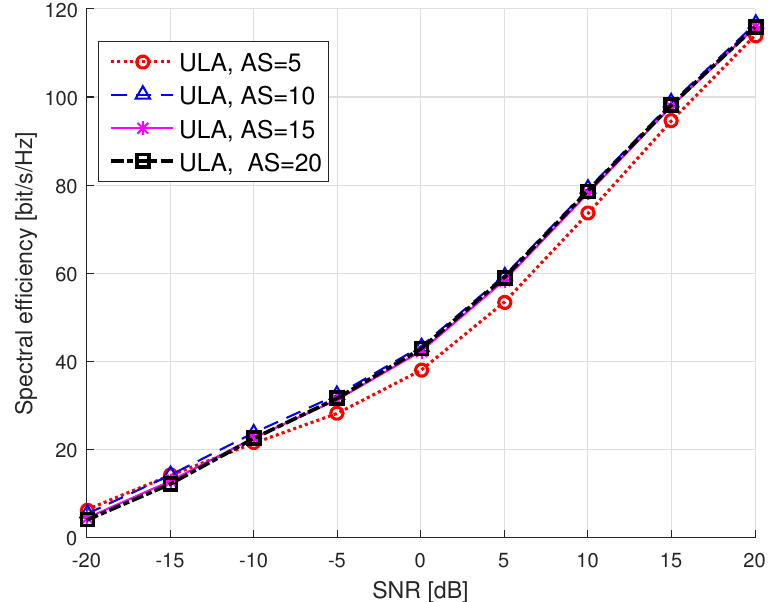
Figure 10. Spectral efficiency vs. SNR in dB for the ULA topology, U = 10 UEs, M = 128, with different values of angular spread α A ( AS )